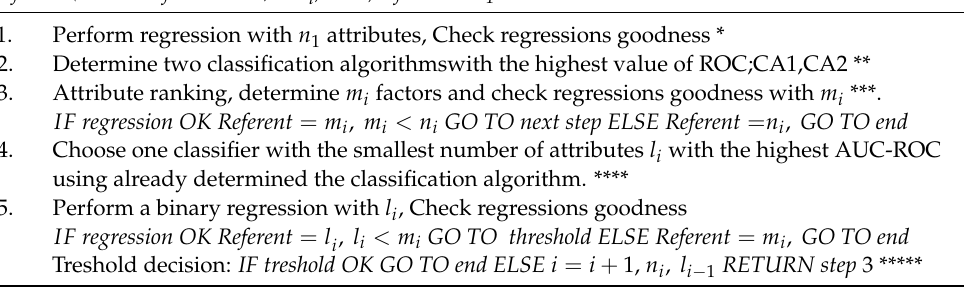
Figure 2. Principle block scheme of algorithm 1 for obtaining significant predictors of health hazards caused by atmospheric factors: one EIT with n-agents system. Algorithm 1: Obtaining predictors of health hazards caused by atmospheric